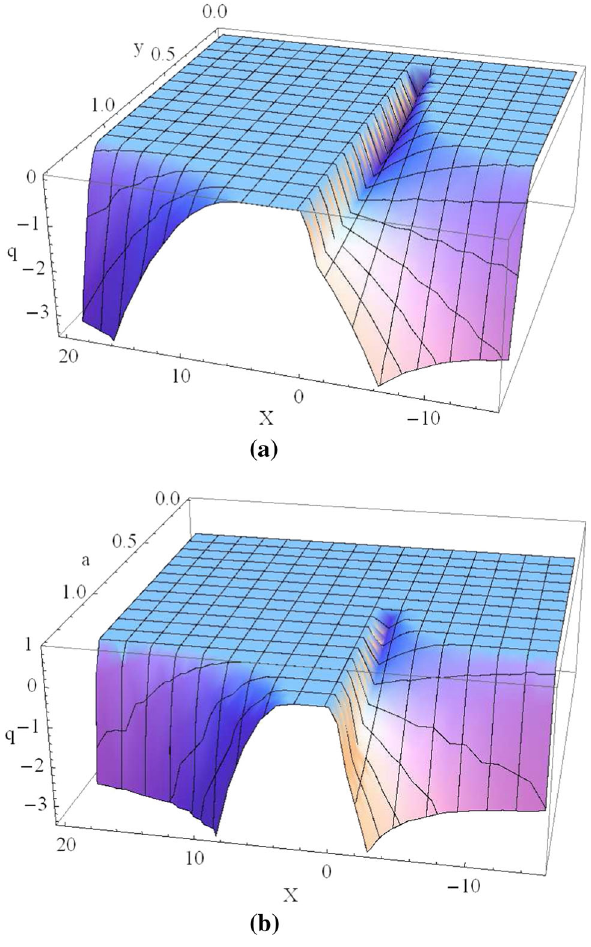
Fig. 4 Parameter spaces ( q − X − y ) for a = 1 ( a ), and ( q − X − a ) for y = 1 ( b ) divided by separating surface in two sub-spaces corre- sponding to allowed (above) and forbidden (beneath) values of kinetic constants q ,